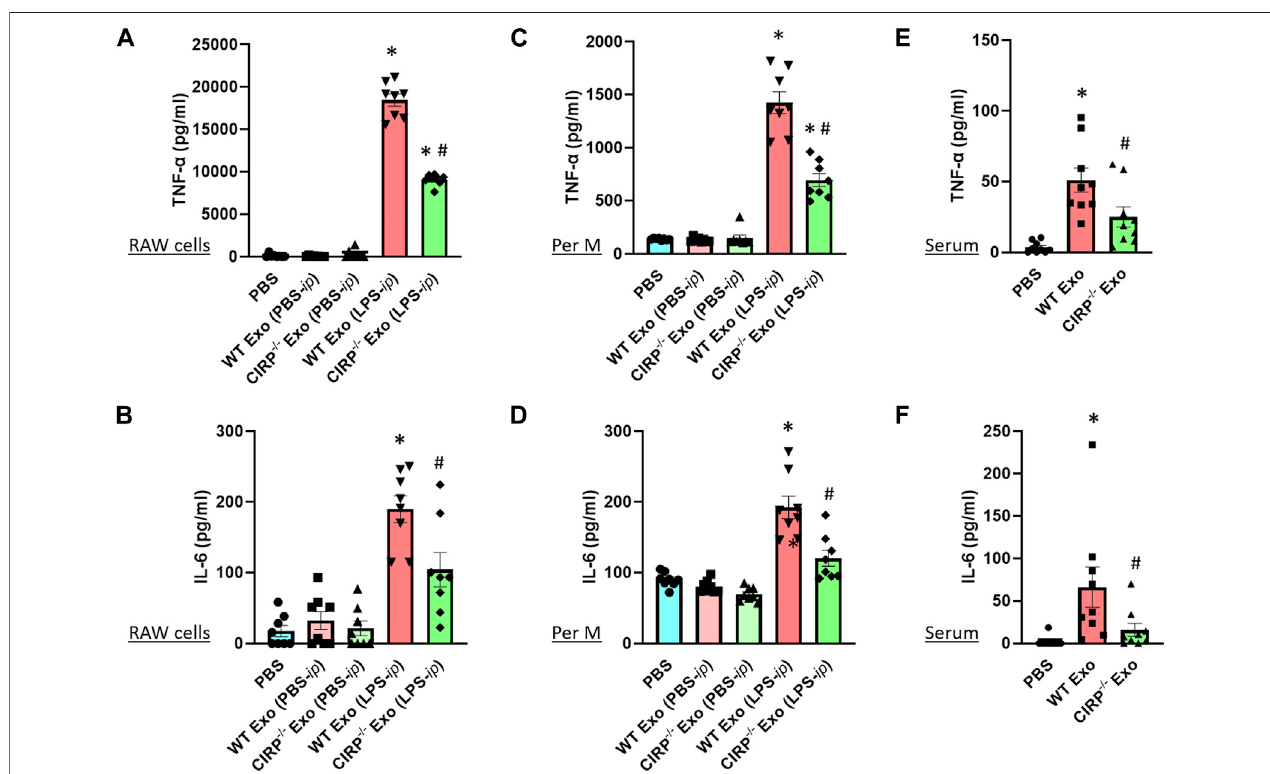
FIGURE 5 | Exosomal eCIRP induces pro-in fl ammatory cytokine production. (A,B) RAW 264.7 cells (10 5 ) and (C,D) peritoneal macrophages (10 5 ) were co- cultured with 5 μ g/ml of exosomes isolated from WT or CIRP − / − mice treated with PBS or LPS. After 20 h supernatants were collected and IL-6 and TNF- α levels were assessed by ELISA. Data are expressed as means ± SE ( n (cid:2) 8 samples/group). The groups were compared by two-way ANOVA and SNK method (* p < 0.05 vs PBS; # p < 0.05 vs exosomes from LPS- i. p. WT mice). (E,F) WT mice were intraperitoneally injected with exosomes isolated from WT or CIRP − / − mice challenged with LPS. After 4 h serum was harvested and IL-6 and TNF- α levels were assessed by ELISA. Data are expressed as means ± SE ( n (cid:2) 9 samples/group). The groups were compared by two-way ANOVA and SNK method (* p < 0.05 vs PBS; # p < 0.05 vs. WT